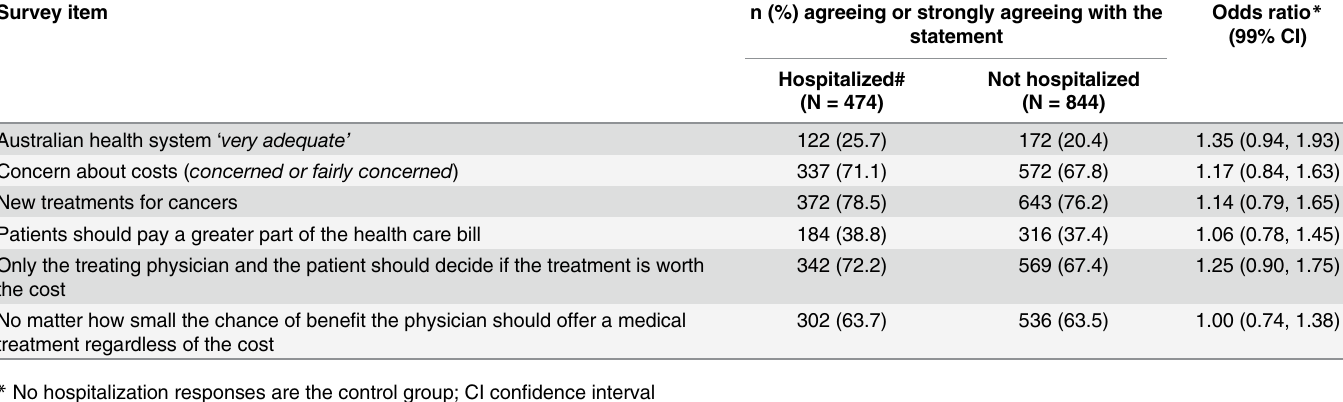
Table 4. Consumer responses with and without recent hospitalization. Survey